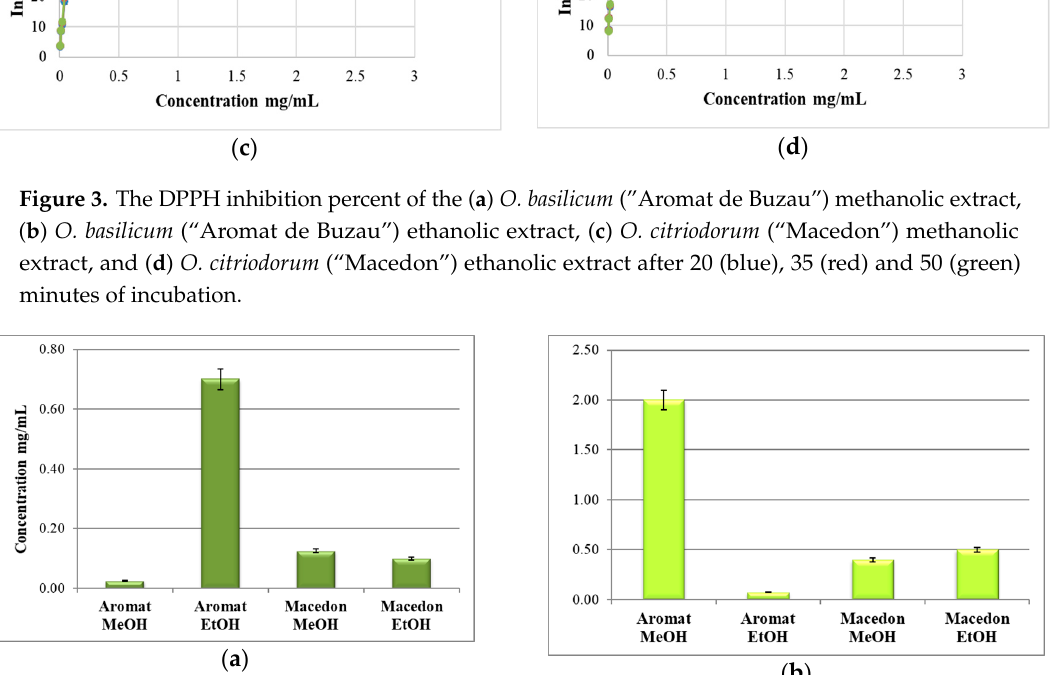
Figure 4. The IC 50 values ( a ) and antioxidant capacity index ( b ) of the basil extracts.